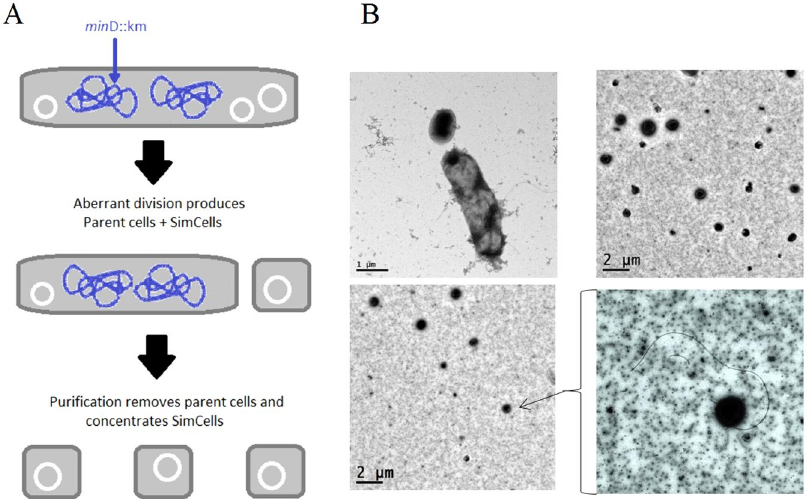
Figure 1. ( A ) Schematic showing how E. coli cells with a min D gene knockout are able to produce SimCells without a chromosome, but with plasmids; ( B ) Electron micrographs showing E. coli MC1000 min D::km producing SimCells of different sizes and morphologies, including